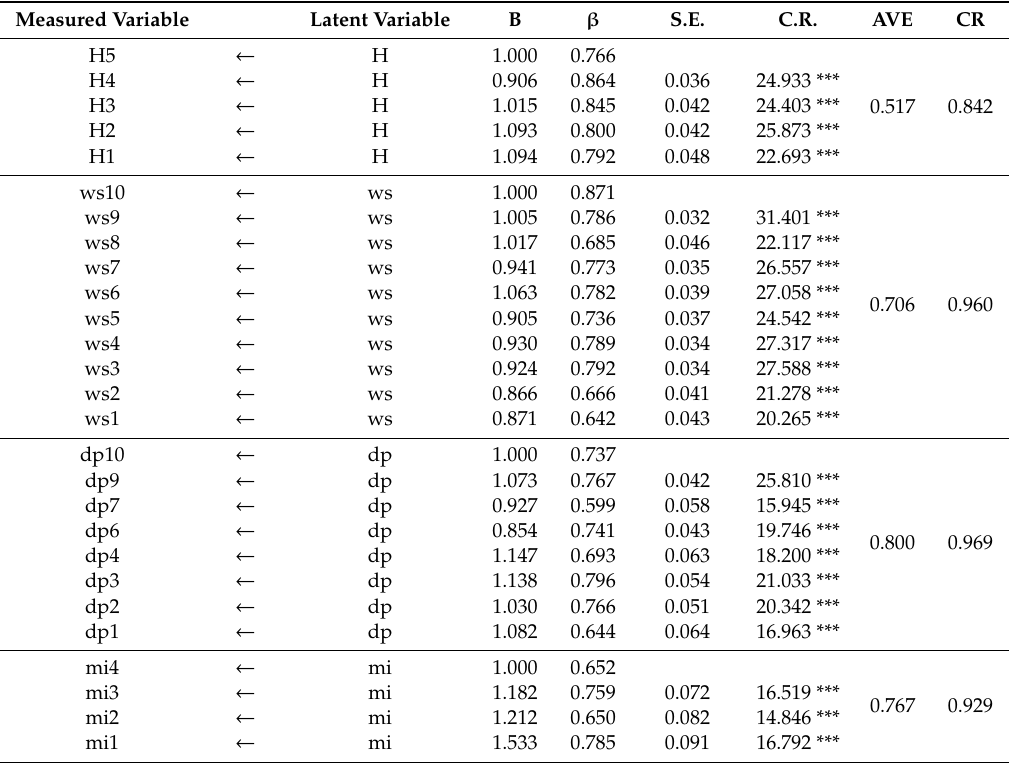
Table 4. Confirmatory factor